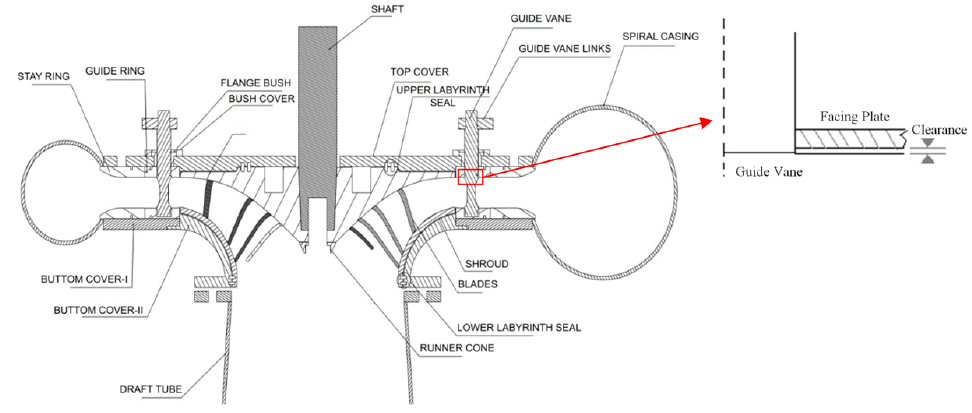
Figure 1. Clearance gap in a Francis Turbine [6].